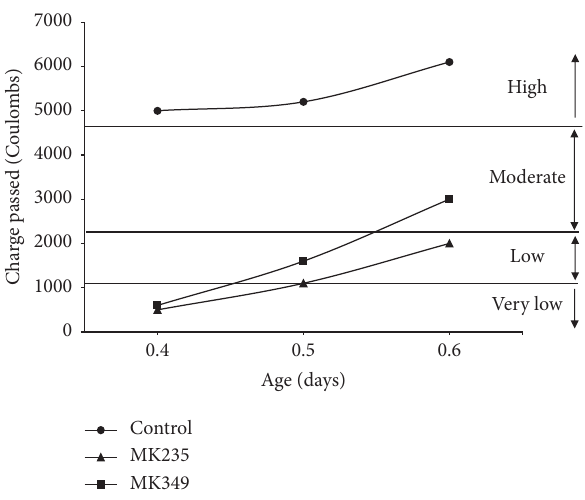
Figure 12: Results from the rapid chloride permeability test (RCPT) after 28 days [23].